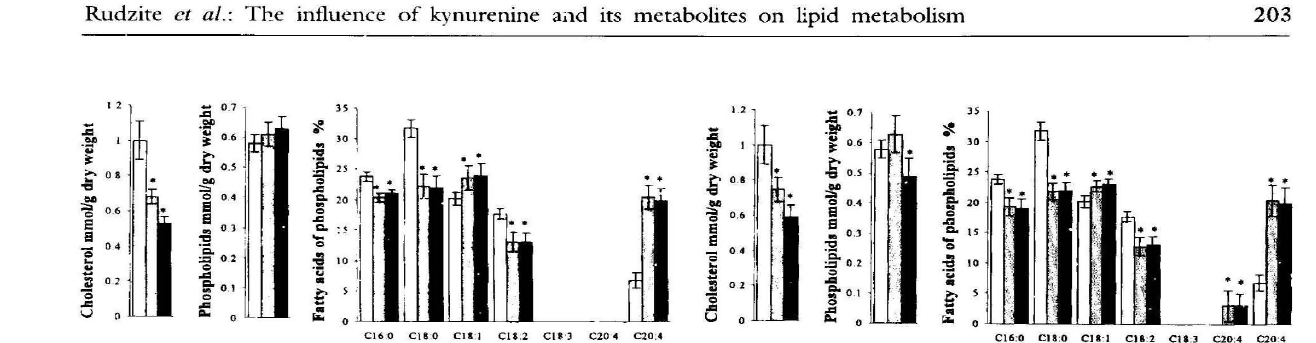
Figure 2. Concentration llle.L:: = ". [l .;': :--:' ,j'-"tcwi .:rnd phospholipids, as \Yell .1, fJ.r.\ -,-,--:..: : .. .-. . 1[1 percent: mean±S.D.) of phospholiph.h 1[1 controls (open bars) and in samples "ith 1.8 I1Ill" l g wcc \\eight (dotted bars) or 4 nmol/g wet weight ::.1t..:nej ['.1..'"5 i 3·hvdroxykynurenine. Samples of rat h\'er tissue hom~genates were used to test tOr phospholipid bios\'mhesis ill vitro. Incubation medium: Krebs -Ringer- phosphate butter, containing 0.3% albumin (pH=7.4 ), fatty acid mixture and glycerol. Samples were in cubated twice tlX 4 h at 37"C. Figure 3. Concentration (mean±S.D .) of cholesterol and phospholipids, as well as fatty acid content (in percent: mean±S.D .) of phospholipids in controls (open bars) and in samples with 2.2 nmol/g wet weight (dotted bars) or with 4 nmoljg wet weight (hatched bars) 3-hy·